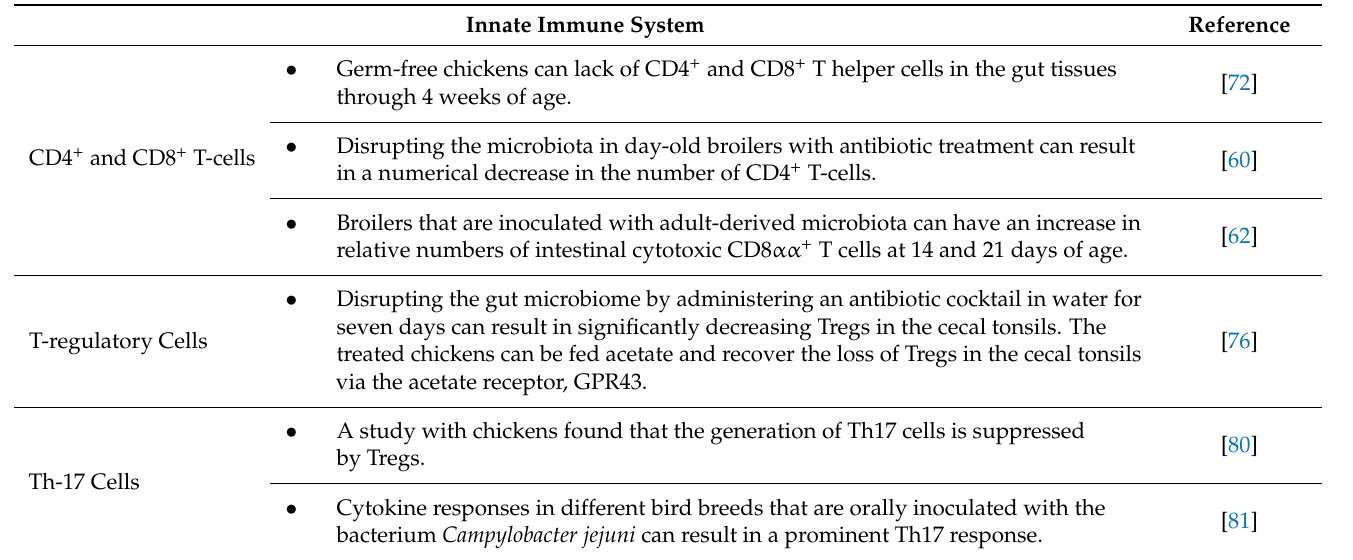
Table 1. Cont. Innate Immune System